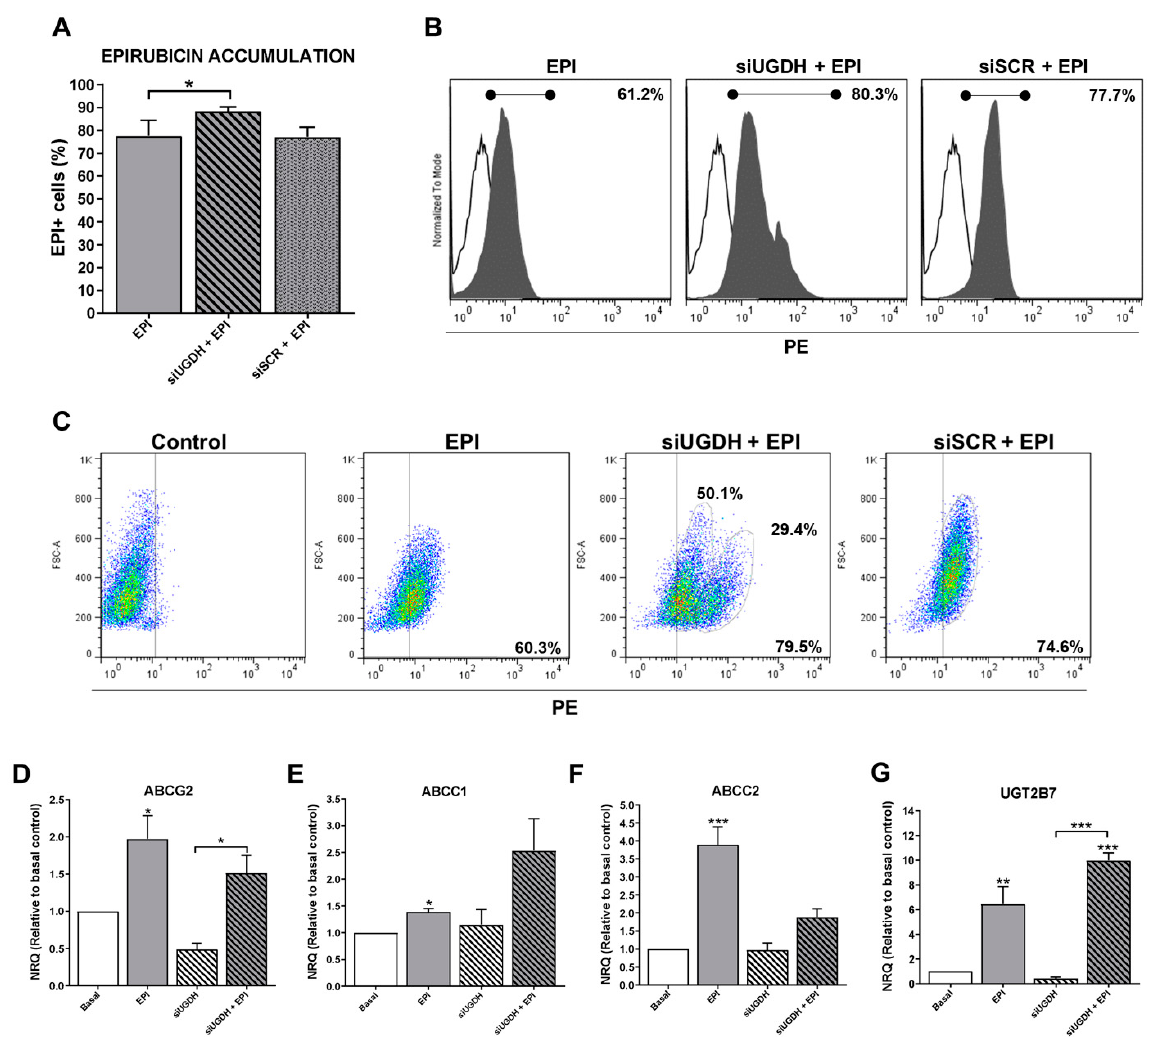
Figure 4. Evaluation of intracellular EPI accumulation in MDA-MB-231 cells after knockdown of UGDH gene. MDA-MB-231 cells were transfected with a specific siRNA against UGDH gene (siUGDH) using a random sequence siRNA as the negative control (siSCR). After 24 h, 1 µ M EPI (EPI) was added to complete 48 h of incubation. Intracellular EPI accumulation was measured by flow cytometry. A control with MDA-MB-231 cells treated only with EPI (EPI) was added to determine the basal uptake of the drug. Bars show the percentage of EPI+ cells determined by comparison with a negative control ( A ). Histograms ( B ) and dot plots ( C ) show the most representative of four independent experiments performed with 50,000 events/condition. n = 4, mean ± SEM, * p < 0.05. To evaluate the expressions of ABCG2 ( D ), ABCC1 ( E ), ABCC2 ( F ), UGT2B7 ( G ), drug efflux pumps and the specific EPI transferase UGT2B7, total RNA was extracted and 2 µ g was reverse transcribed by RT-PCR. cDNAs were subjected to real-time quantitative PCR using SYBR Green. Results were normalized using β -actin as reference gene and all determinations were performed as duplicates. n = 3, mean ± SEM, * p < 0.05 ** p < 0.01 *** p < 0.001.